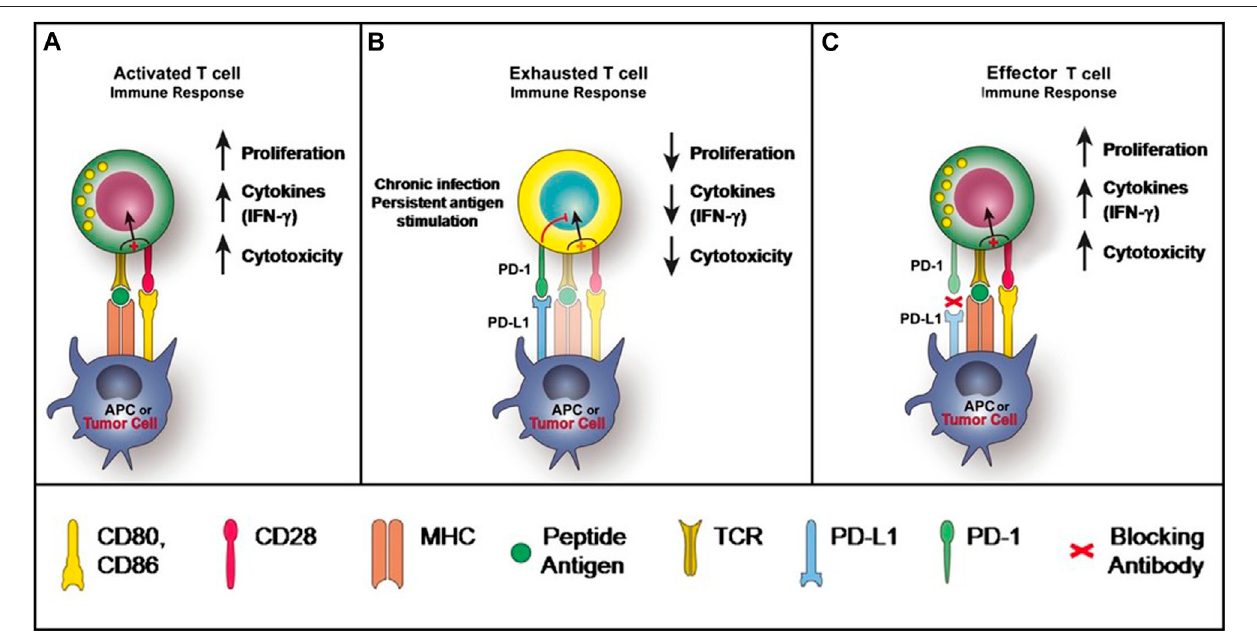
FIGURE 1 | PD-1 and PD-L1 Signaling Pathway McDermott and Atkins